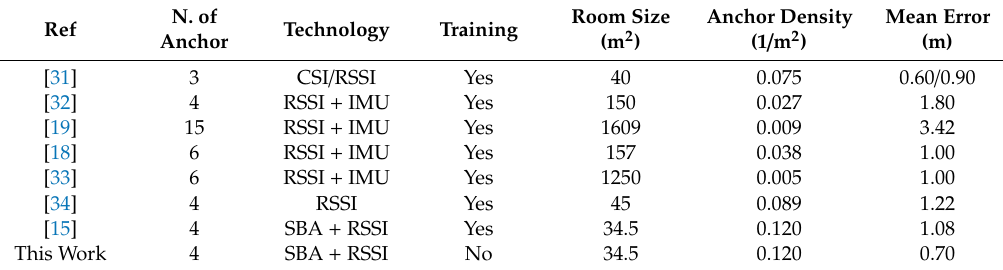
Table 4. State of art